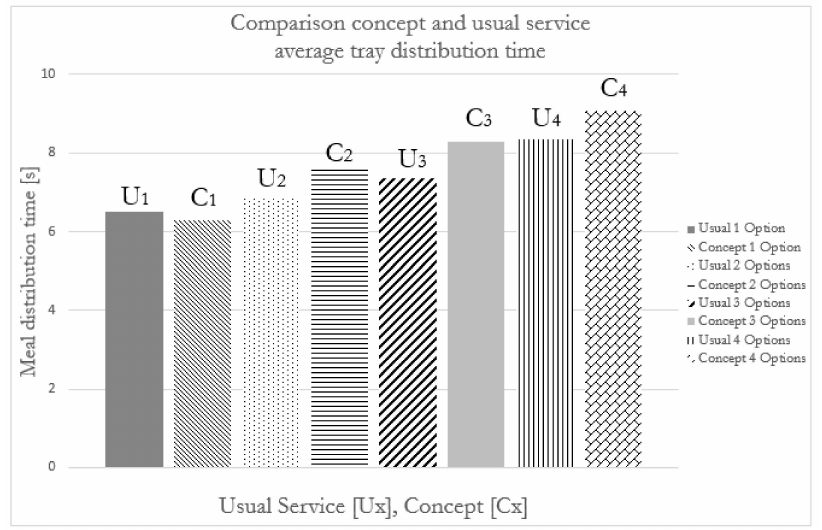
Figure 23. Comparison of the standard service with the new concept service. The test results for the meal distribution service including 5%, 10%, and 20% pre- ordering are presented in Figures 24 and 25. The baseline for comparison is the standard meal service with two options for simplification.